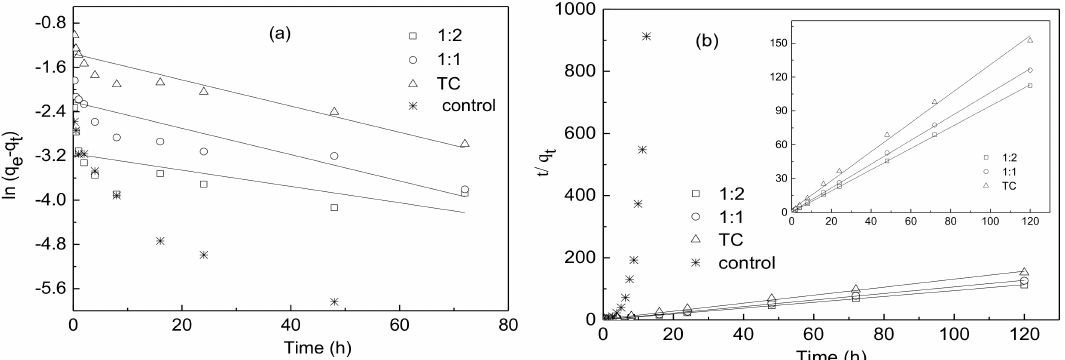
Figure 5. Adsorption kinetic curves of TC with or without Cu(II) onto water hyacinth roots fitted by ( a ) pseudo-first-order kinetic model ( b ) pseudo-second-order kinetic model Dots: measured data, solid line: curve fitted into the